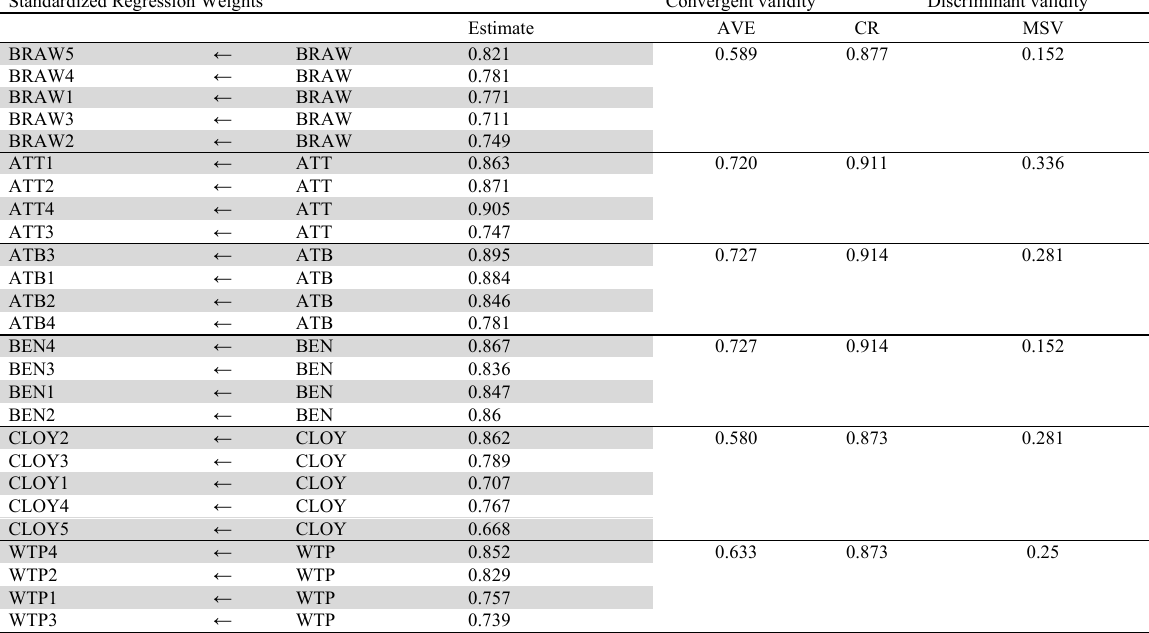
Convergent and Divergent validity of constructs Standardized Regression